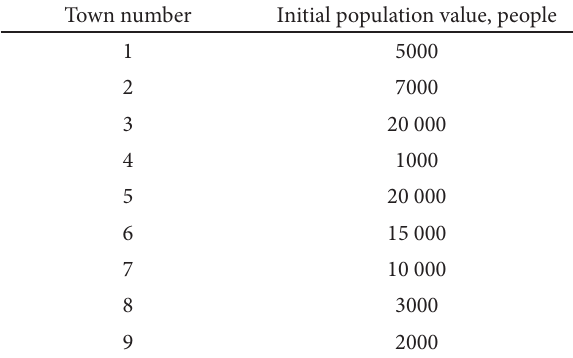
Table 5. Tentative population of each town Town